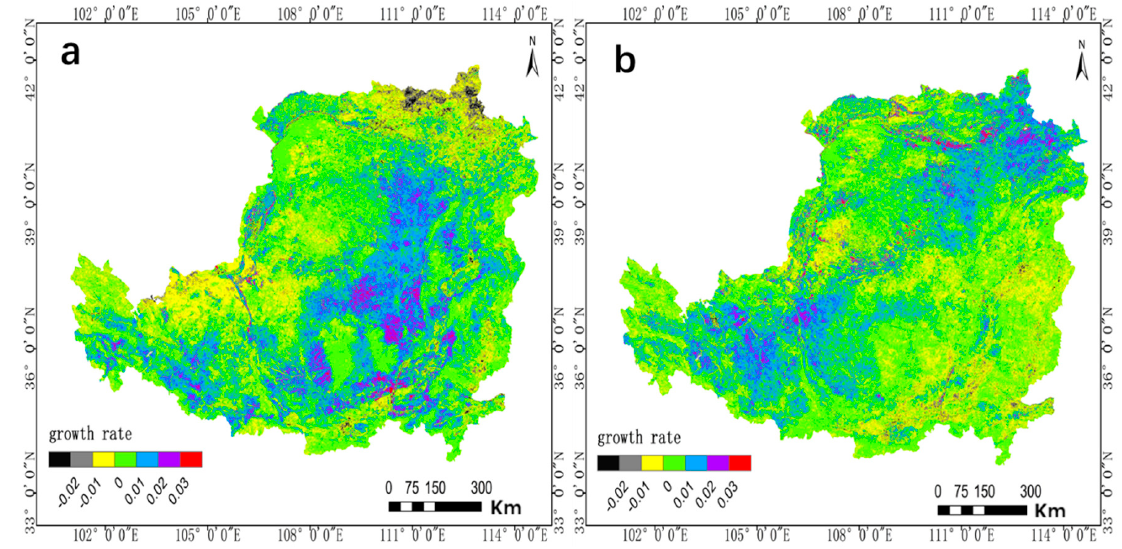
Figure 3. ( a ) Variation trend of NDVI in the Loess Plateau from 2001 to 2010. ( b ) Variation trend of NDVI in the Loess Plateau from 2011 to 2020.